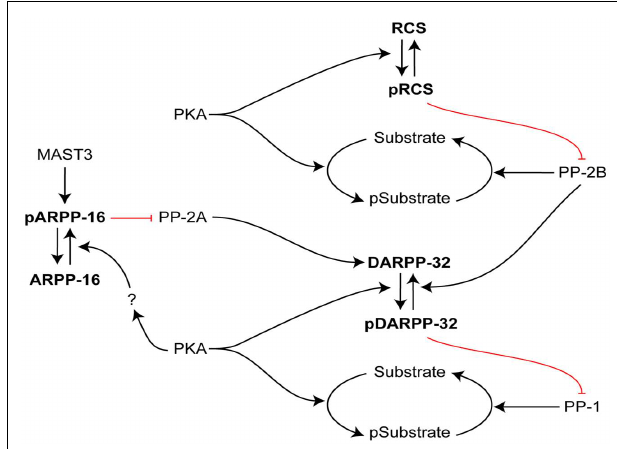
FIGURE 3 | Interactive roles of DARPP-32, RCS, andARPP-16 in regulation of signal transduction in striatal MSNs. The efficacy of phosphorylation by PKA of numerous PKA/PP1 substrates is increased by PKA phosphorylation of DARPP-32, which inhibits PP1. In an analogous manner, the efficacy of phosphorylation by PKA of numerous PKA/PP2B substrates is increased by PKA phosphorylation of RCS, which inhibits PP2B. In contrast, ARPP-16 appears to be basally phosphorylated by MAST3 kinase, leading to inhibition of the action of PP2A on selective substrates includingThr75 of DARPP-32 (a site that acts basally to attenuate PKA’s ability to phosphorylateThr34 of DARPP-32; not shown, see Figure 2 ). PKA may modulate the ability of MAST to phosphorylate ARPP-16 or influence the effect of ARPP-16 on PP2A. RCS and ARPP-16 in different ways may act to control DARPP-32’s ability to inhibit PP1.